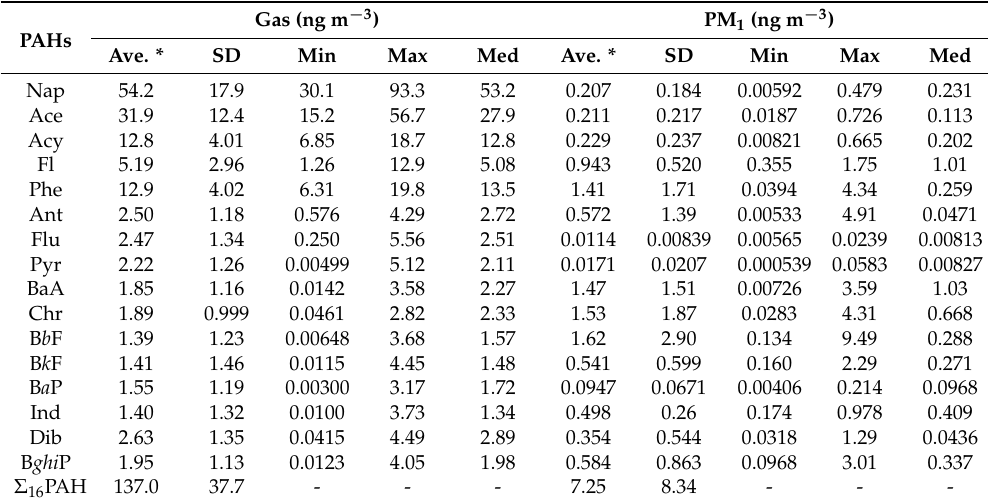
Table 4. Average ambient levels of PAHs observed in the gas and PM 1 phases at the CEN and TLA monitoring sites in the GMA.